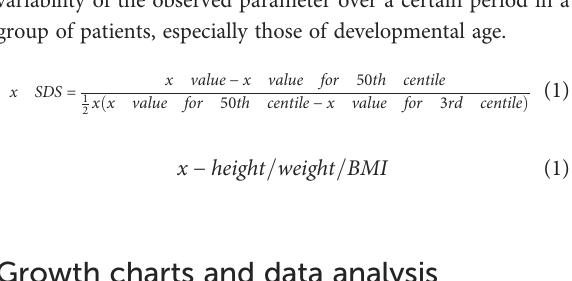
TABLE 3 The prevalence of selected common comorbidities in children with DS reported by parents. Comorbidities